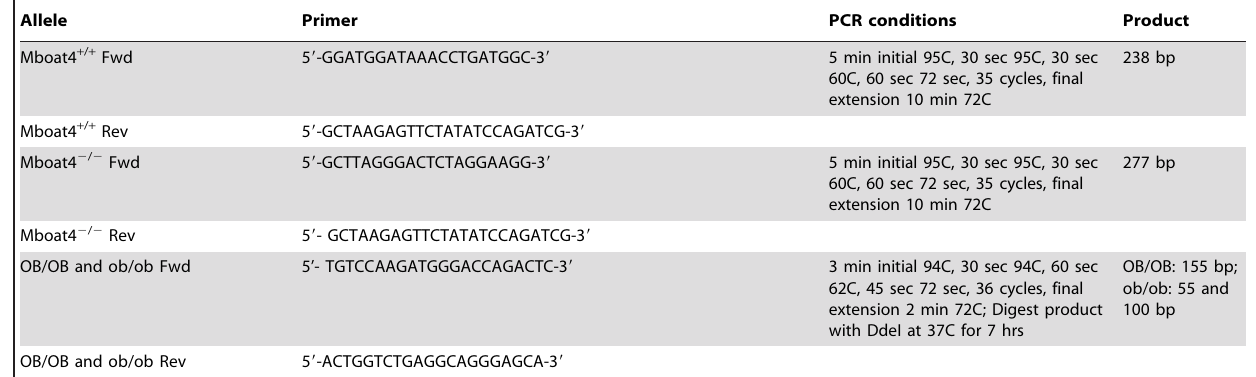
Table 1. Genotyping conditions.